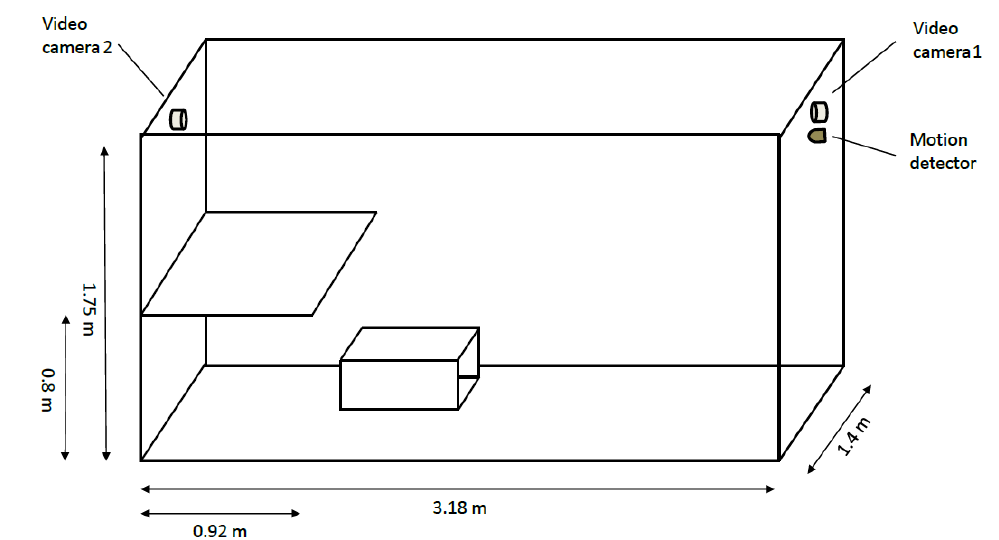
Figure 1. Illustration of the dimensions of the cage in which foxes were